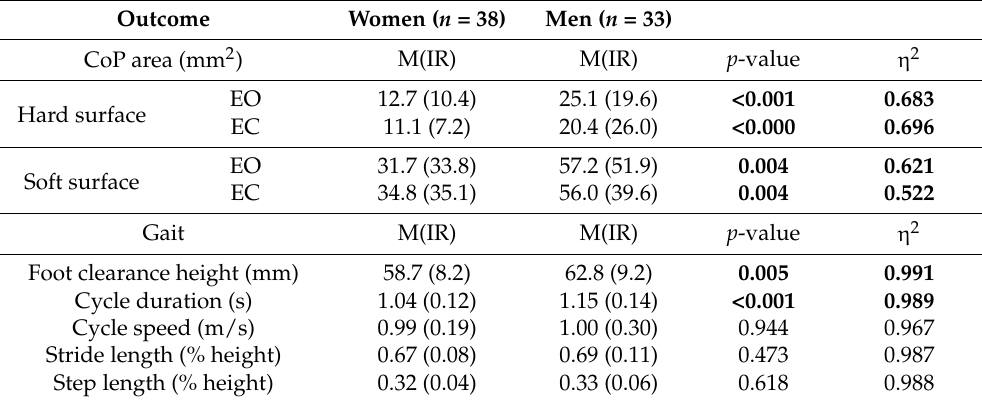
Table 2. Comparison by sex of the postural balance and gait variables. Data are presented as Median (interquartile